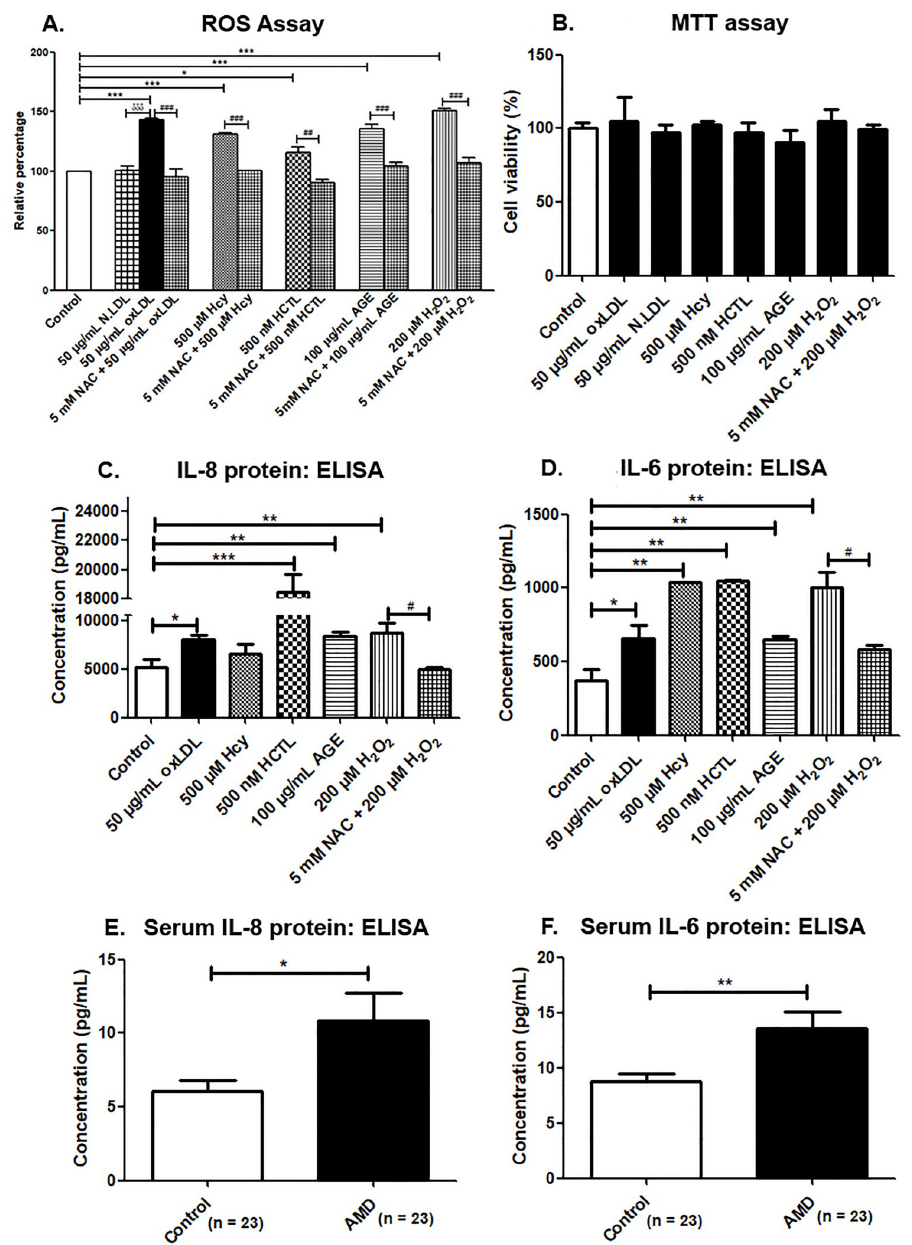
Fig 1. ROS assay and pro-inflammatory cytokine levels. (A) ROS assay in ARPE-19 cells by DCFH-DA method, (B) MTT assay for cell viability in ARPE-19 cells, (C) IL-8 and (D) IL-6 estimation in basal conditioned media of ARPE-19 cells exposed to pro-oxidants conditions for 24 h by ELISA, (E) Serum IL-8 levels and (F) Serum IL-6 levels. Values are expressed as Mean ± SEM. � ; # p < 0 . 05 , �� , ## p < 0 . 01 , ��� ; ###; δδδ p < 0 . 001 , considered as significant. � Control vs pro- oxidants, # pro-oxidants vs NAC, δ oxLDL vs